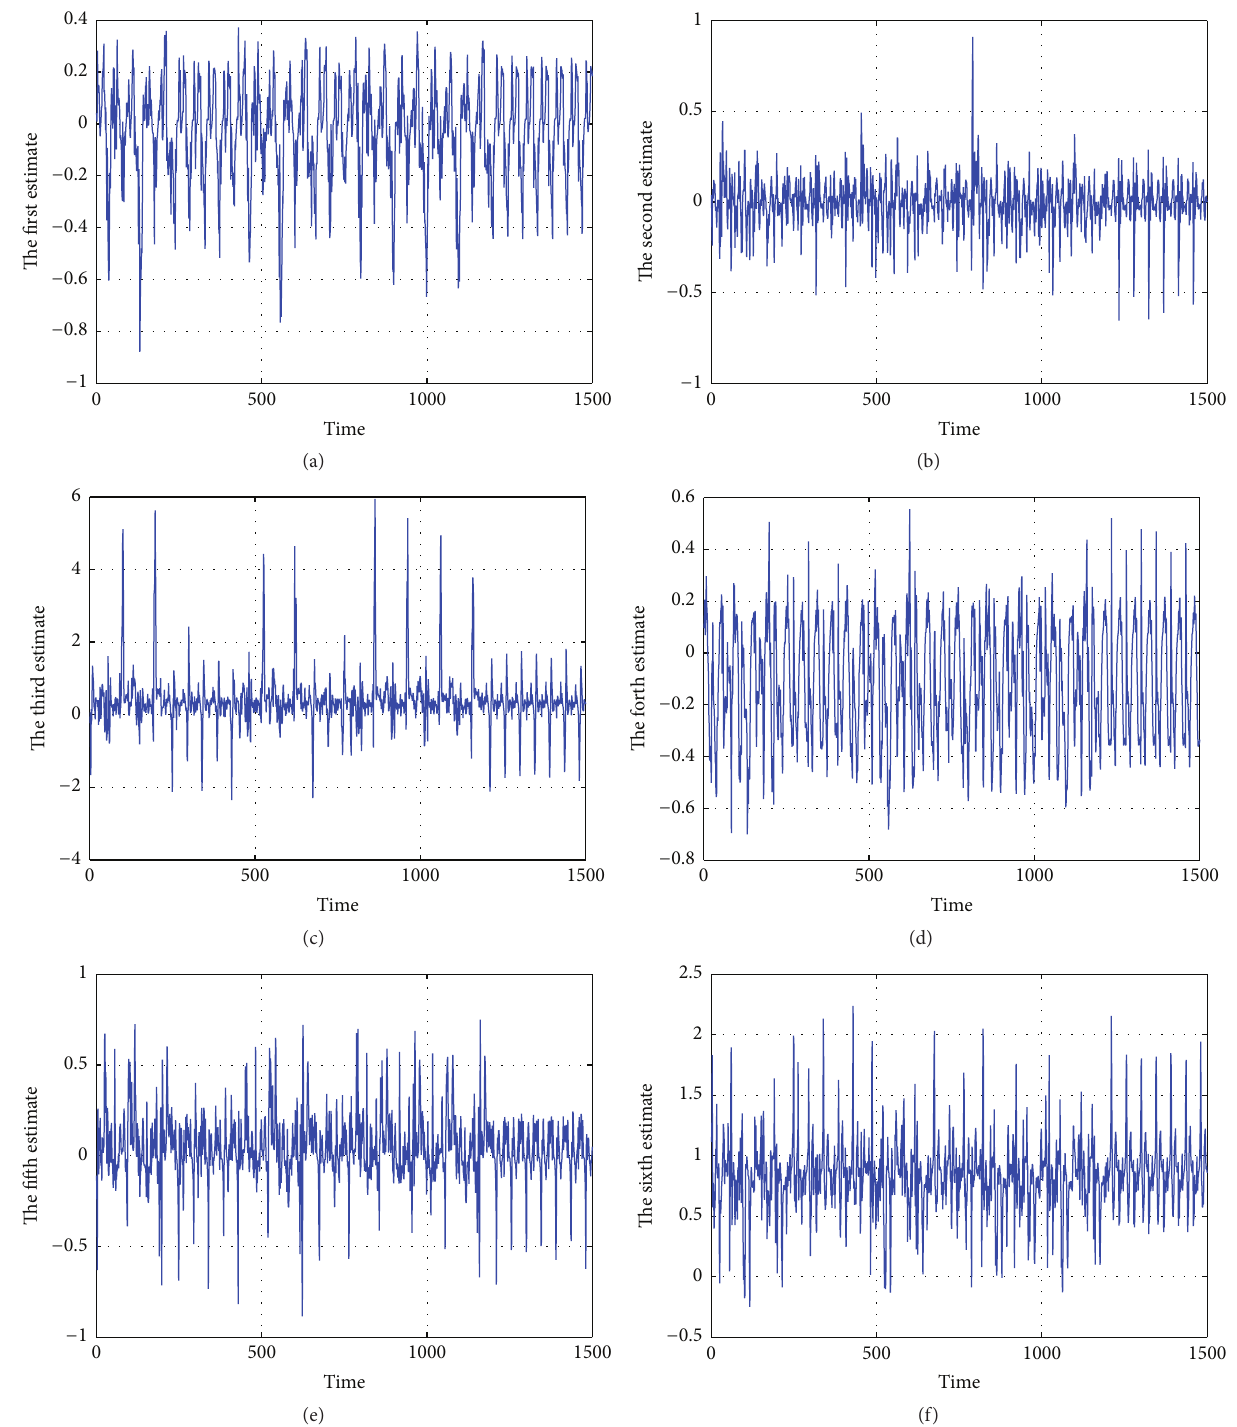
Figure 10: The functional coefficients’ estimations: (a)–(f) the estimated values from 𝑥 𝑡−(𝑚−1)𝜏 to 𝑥 𝑡 ,